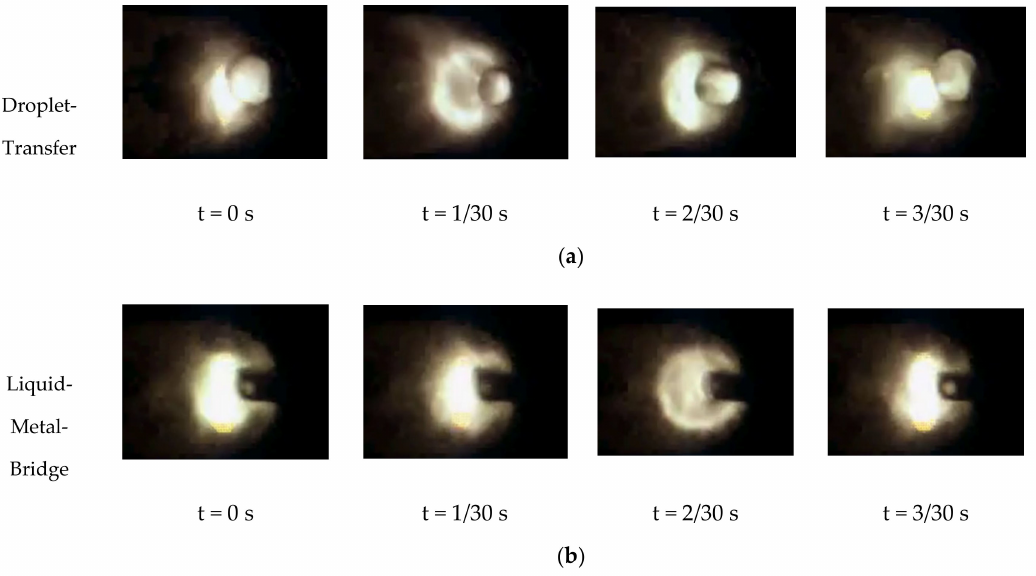
Figure 13. Material transfer modes in electron beam additive manufacturing recorded via CCT camera: ( a ) droplet transfer and ( b ) liquid metal bridge